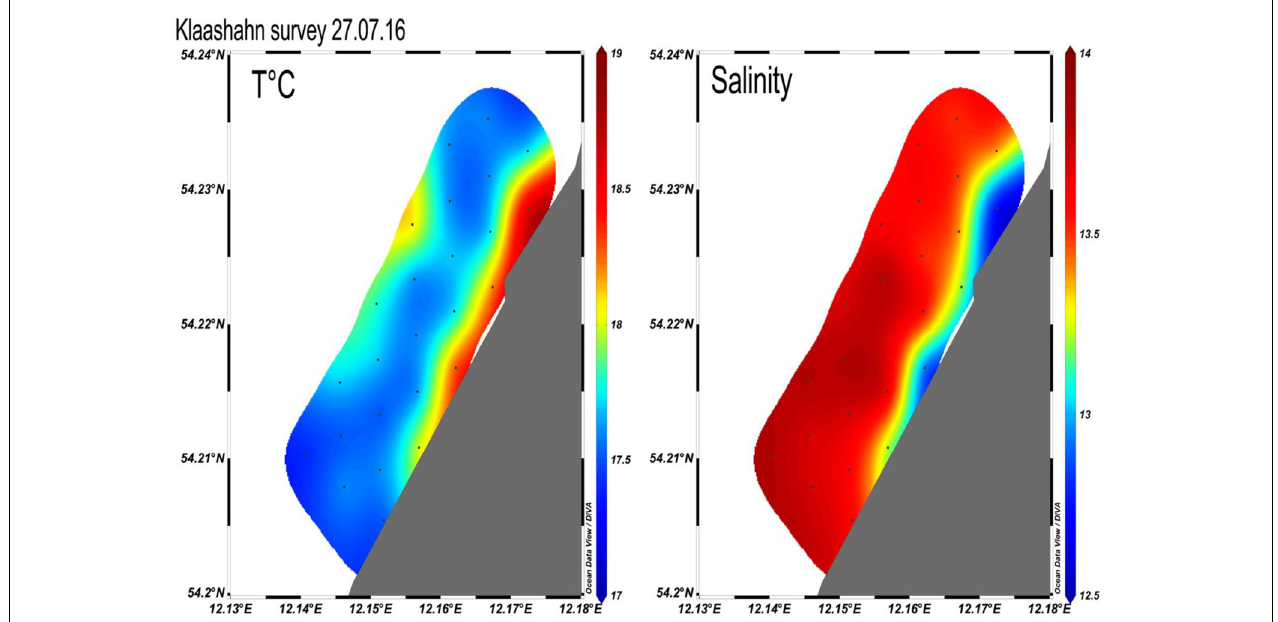
FIGURE 9 | Temperature and salinity (PSU) distribution in front of the experimental coastal peatland (summer